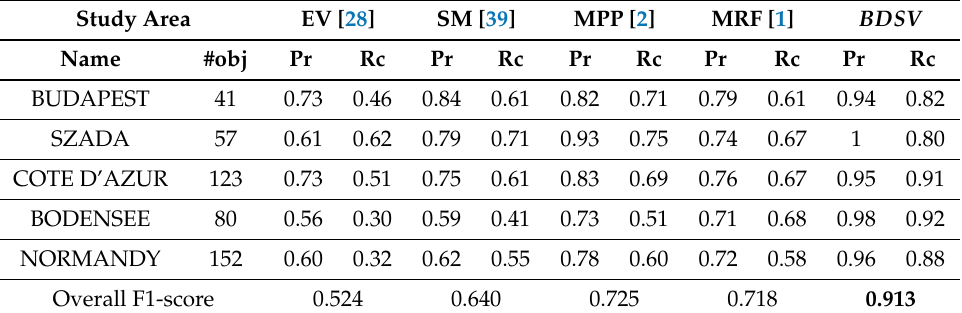
Table 4. Pixel-level accuracy assessment of benchmarked algorithms over the SztaKi–Inria